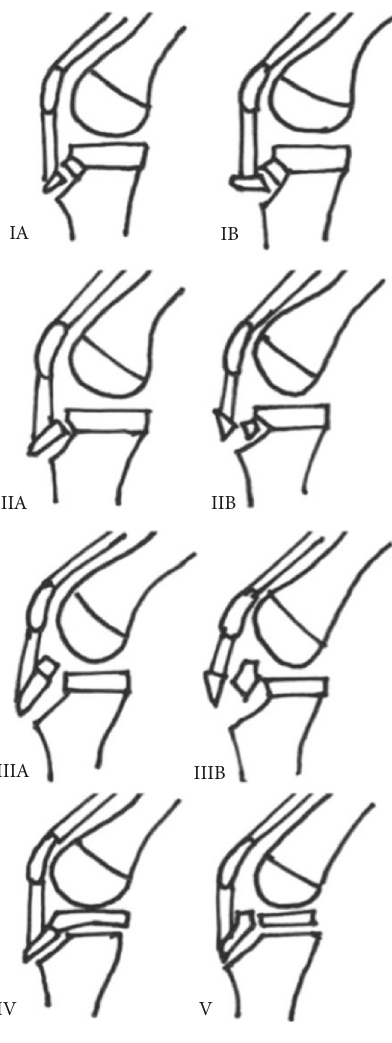
Figure 2: Classification of proximal tibial tuberosity fractures in adolescents [adapted from Ryu and McKoy].